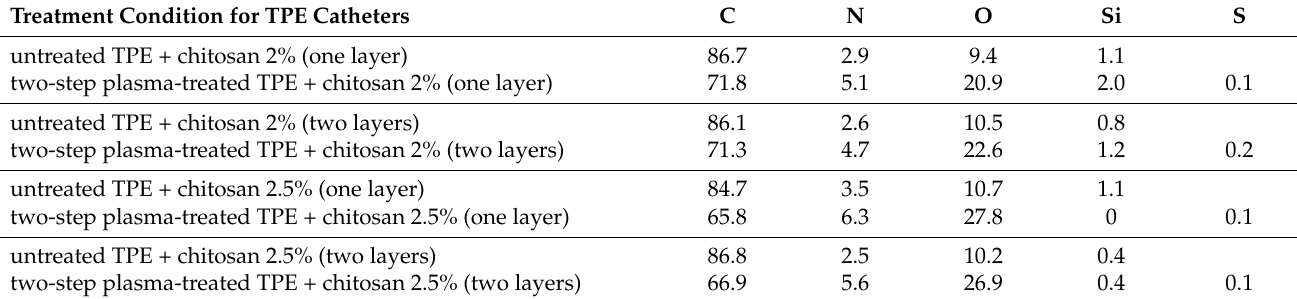
Table 6. XPS composition of TPE catheters with the coating (in atomic